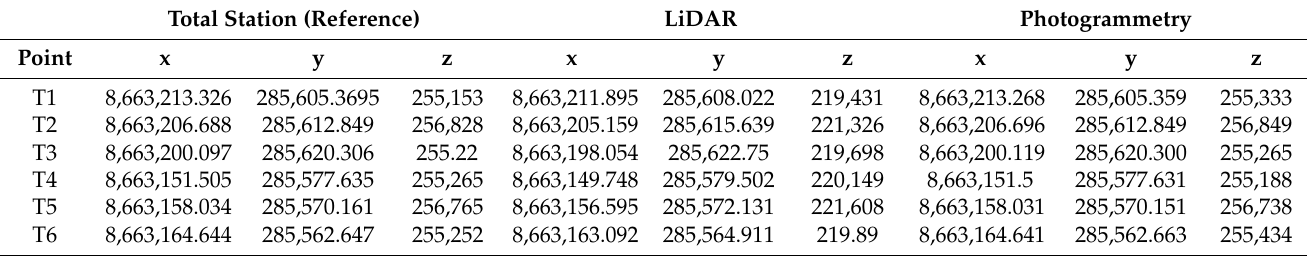
Table 7. Coordinates of the surveyed points obtained with a total station, LiDAR and photogrammetry.